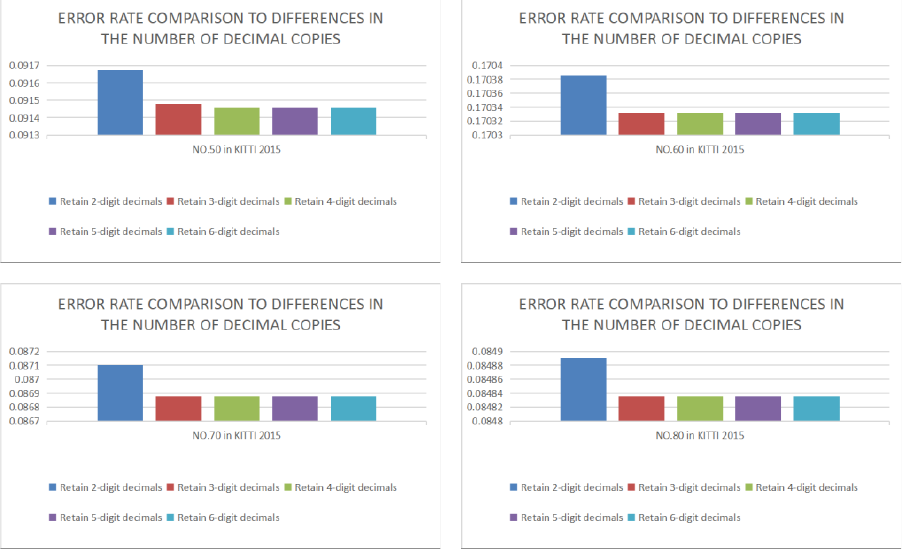
Figure 5. Verification of copied decimal parts .